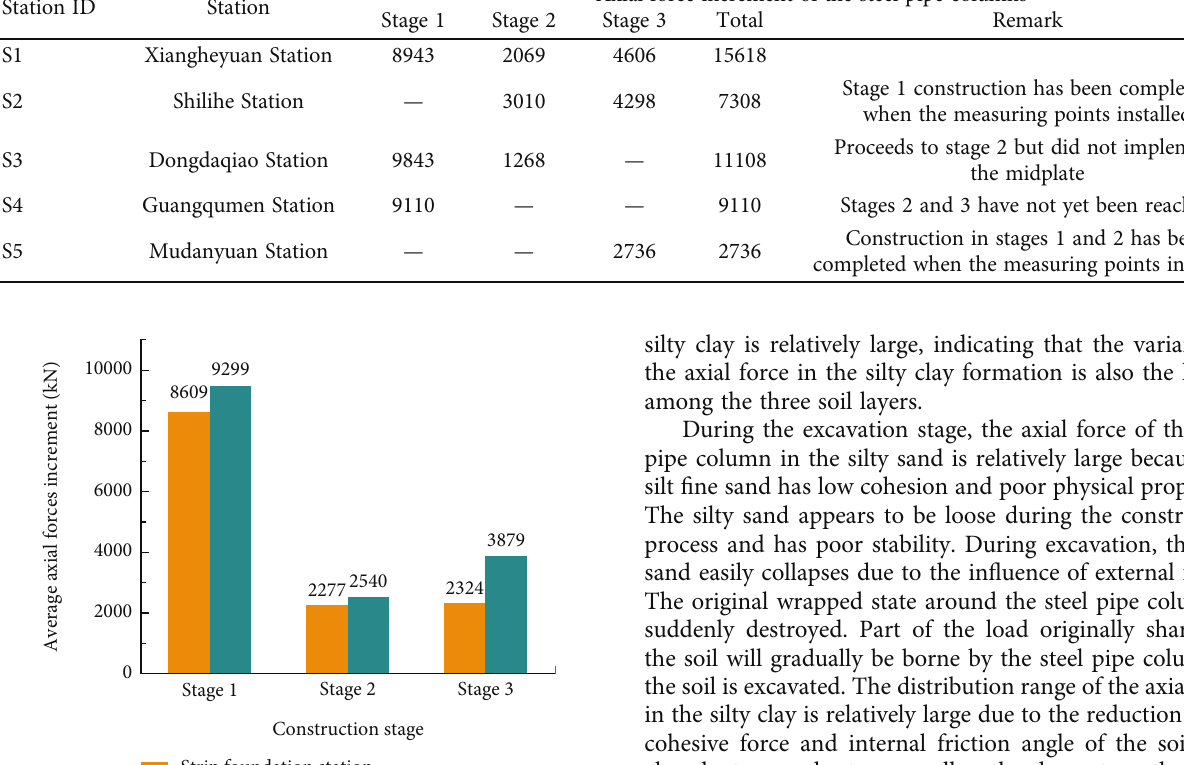
Table 4: Axial forces increment in di ff erent construction stages of the strip foundation stations (unit: kN). Station ID Station